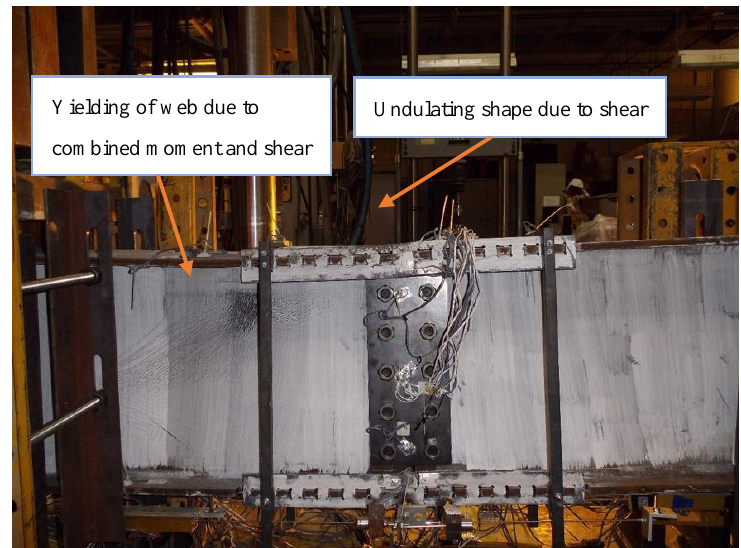
Figure 11. Top side angles after beam test-2.